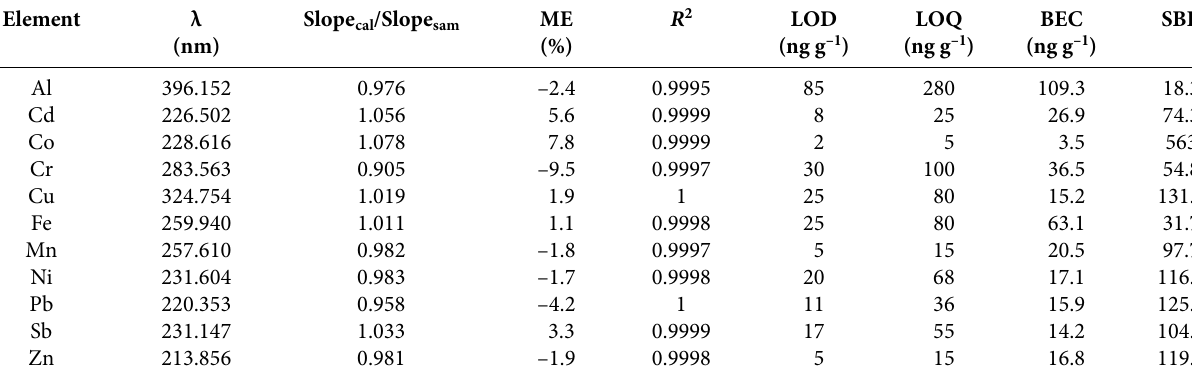
Table 2. Analyte line selected with the ratio slope cal /slope sam , matrix effect (ME), BEC and SBR, as well as coefficient of determination ( R 2 ), LOD and LOQ of the calibration for each metal determination. Plasma view mode: axial. Element